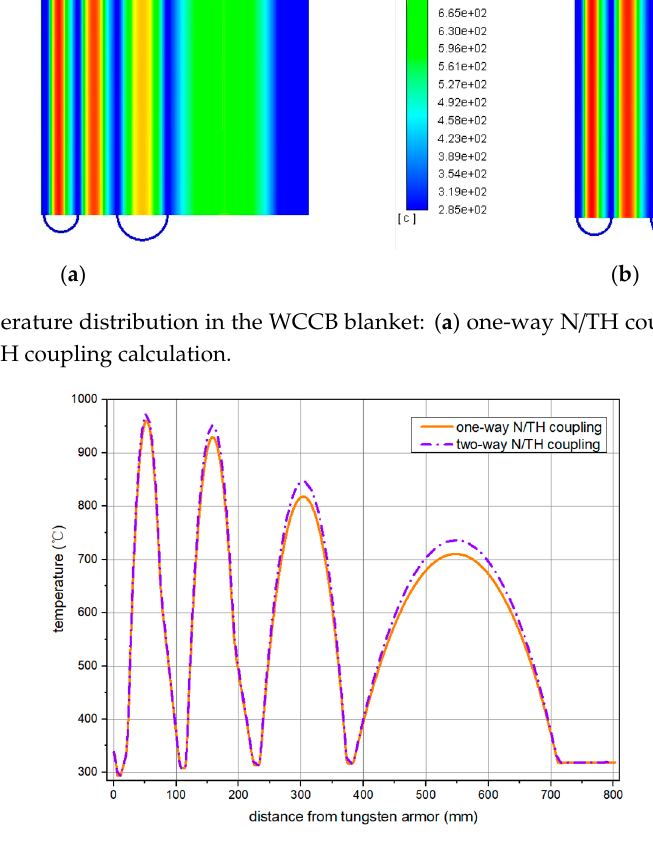
Figure 22. Comparison of the temperature distribution along the radial direction.